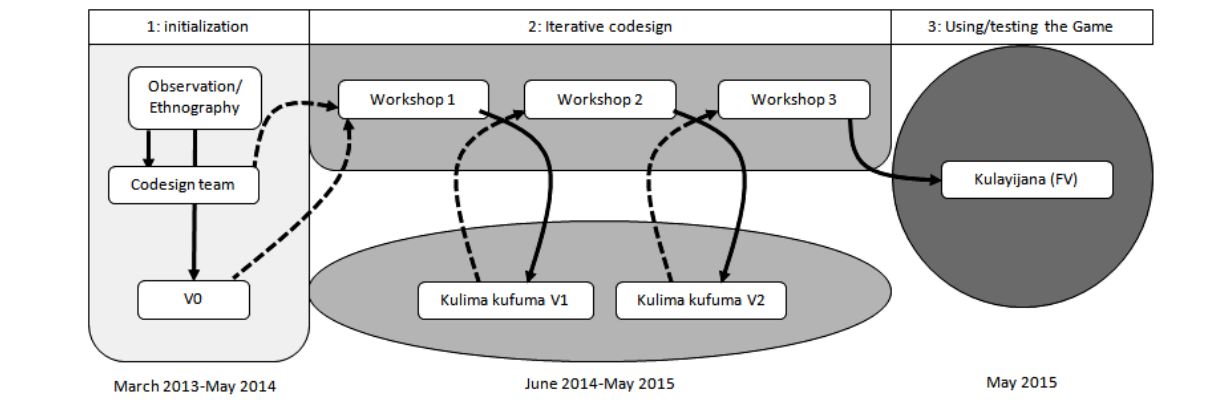
Fig. 2. Codesign of the role-playing game through an iterative process. Each workshop provides new elements or modifications that researchers use to improve the model/game. Each set of modifications is tested in the following workshop in order to validate the changes made (e.g., Souchère et al.